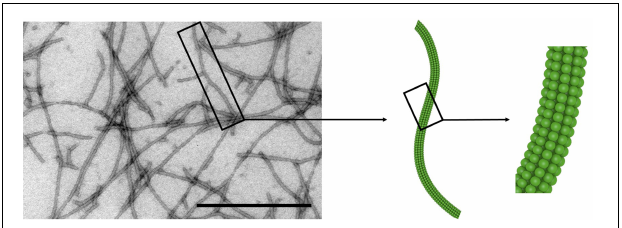
FIGURE 1 | Potato virus X particles. Transmission electron micrograph and schematic representation of PVX. Scale bar = 500 nm. Adapted from Lauria et al.